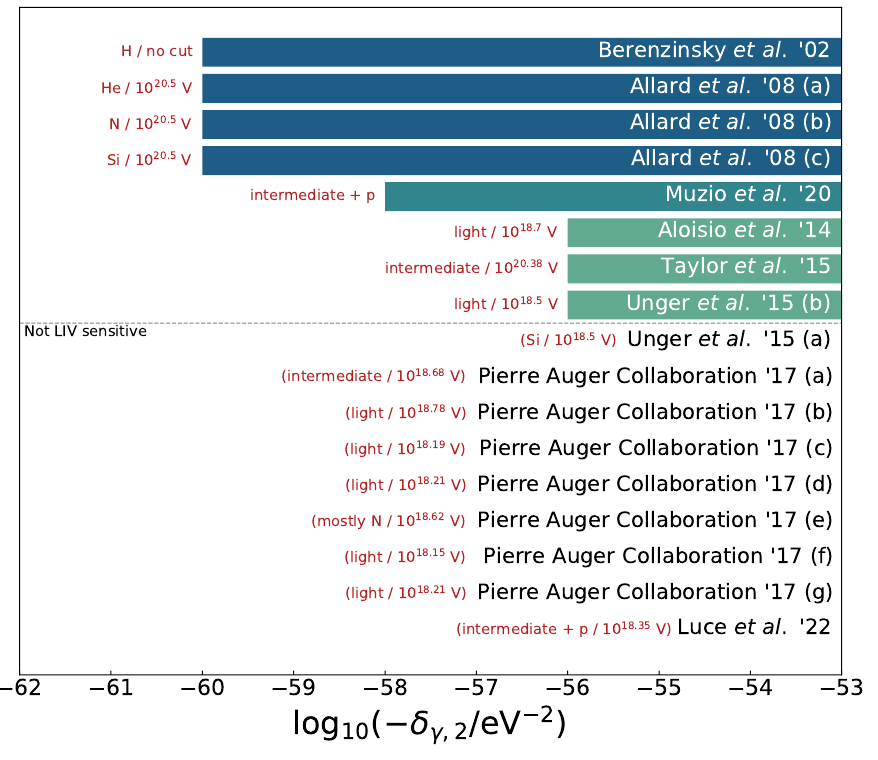
Figure 6. Same as Figure 4, but for n =